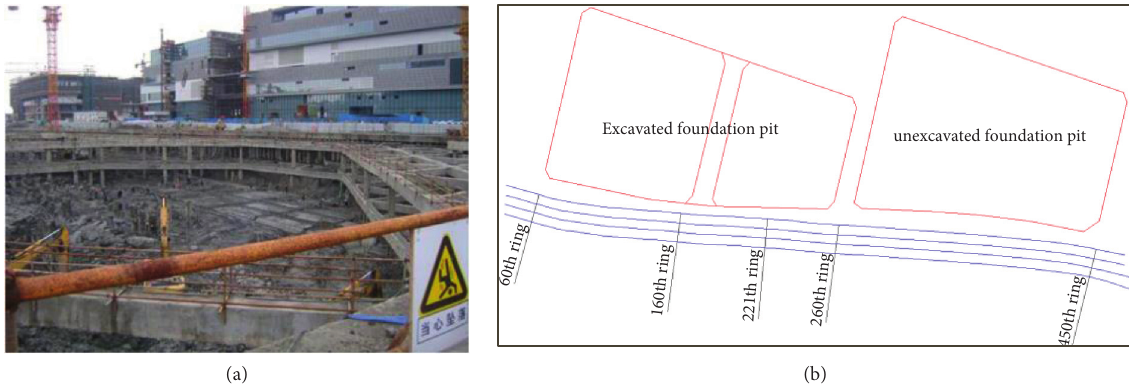
Figure 2: Position relationship between interval tunnel and the foundation pit. (a) Site photo. (b) Plan